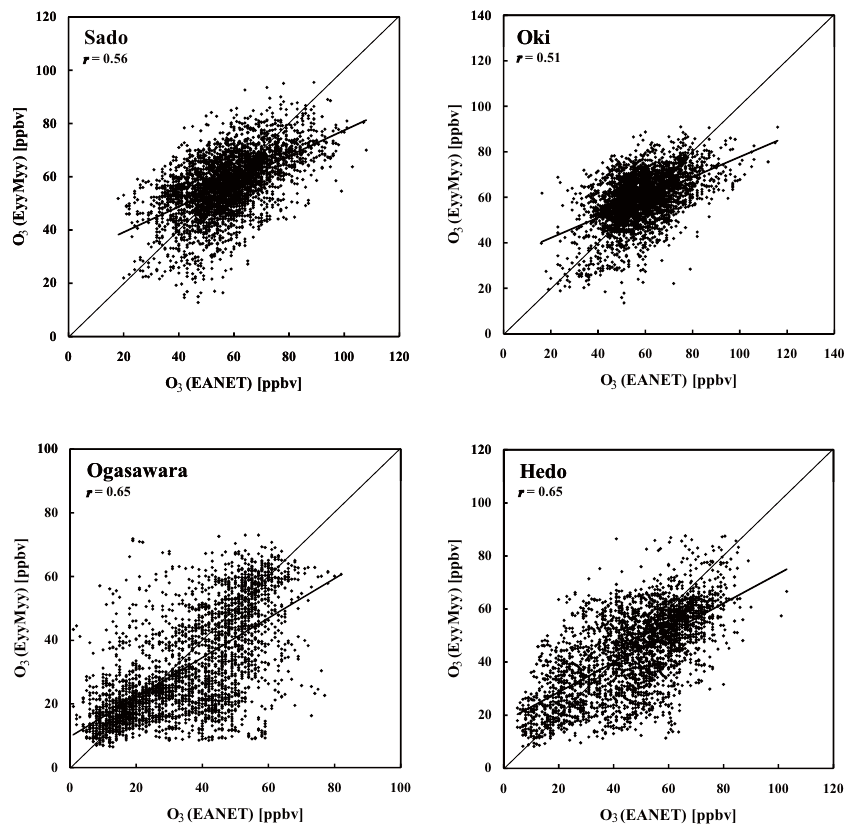
Fig. 3. Comparison of observed and simulated hourly mean O 3 mixing ratios at four Japanese remote sites (Sado, Oki, Ogasawara, and Hedo). Hourly averaged data during springtime of all periods shown in Table 2 are plotted at three-hour intervals. The linear regression lines of hourly averaged O 3 values between the observations and simulations are also shown. The E yy M yy scenario was used for the model simulation.